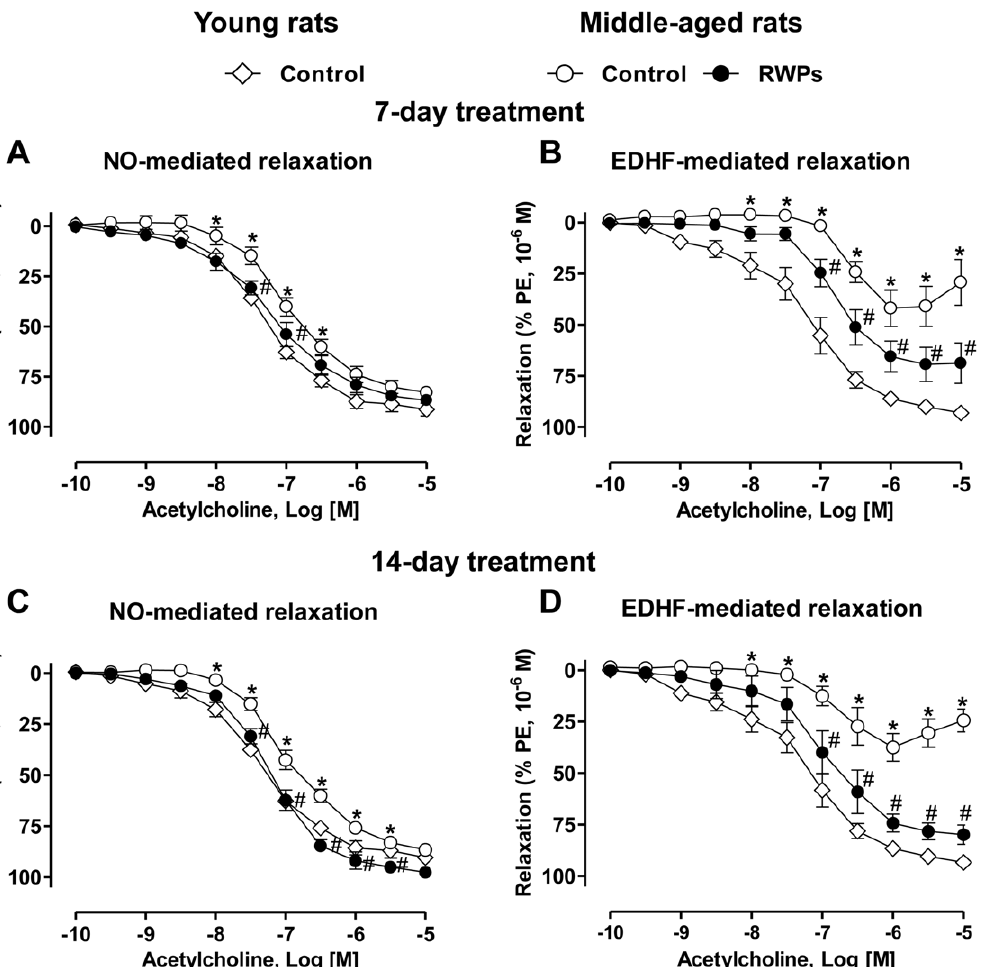
Figure 2. Intake of RWPs improves blunted NO- and EDHF-mediated relaxations in the mesenteric artery of middle-aged rats. Young (16-week old) and middle-aged (46-week old) control rats received solvent (ethanol, 3% v/v) in the drinking water and middle-aged treated rats received RWPs (100 mg/kg/day) for either 7 (a, b) or 14 days before sacrifice (c, d). NO-mediated relaxations were determined in rings contracted with phenylephrine (1 m M) in the presence of indomethacin (10 m M) and charybdotoxin (CTX, 100 nM) plus apamin (APA, 100 nM) to inhibit the participation of prostanoids and EDHF, respectively (a, c). EDHF-mediated relaxations were determined in the presence of indomethacin (10 m M) and N v -nitro-L-arginine (L-NA, 300 m M) to rule out the participation of prostanoids and NO, respectively (b, d). Results are shown as mean 6 SEM of 5 to 6 different rats. * P , 0.05 indicates a significant difference versus the young rat control group and # P , 0.05 a significant difference versus the middle- aged rat control